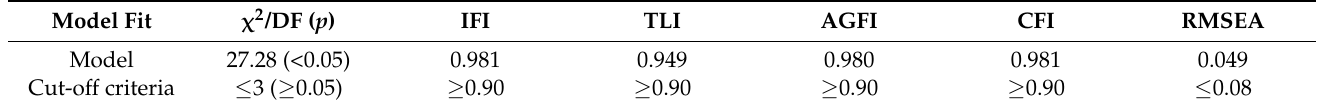
Table 8. Structural model fit